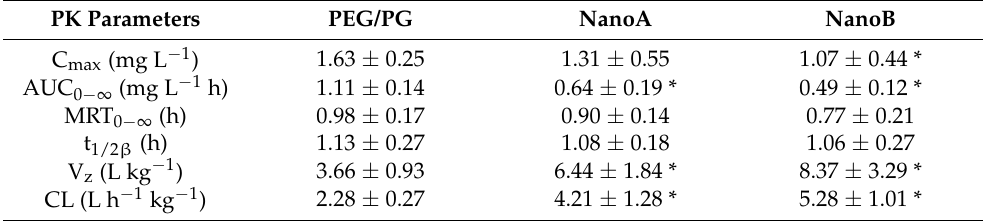
Table 5. PK parameters after intravenous administration of PEG/PG solution and NanoA and NanoB